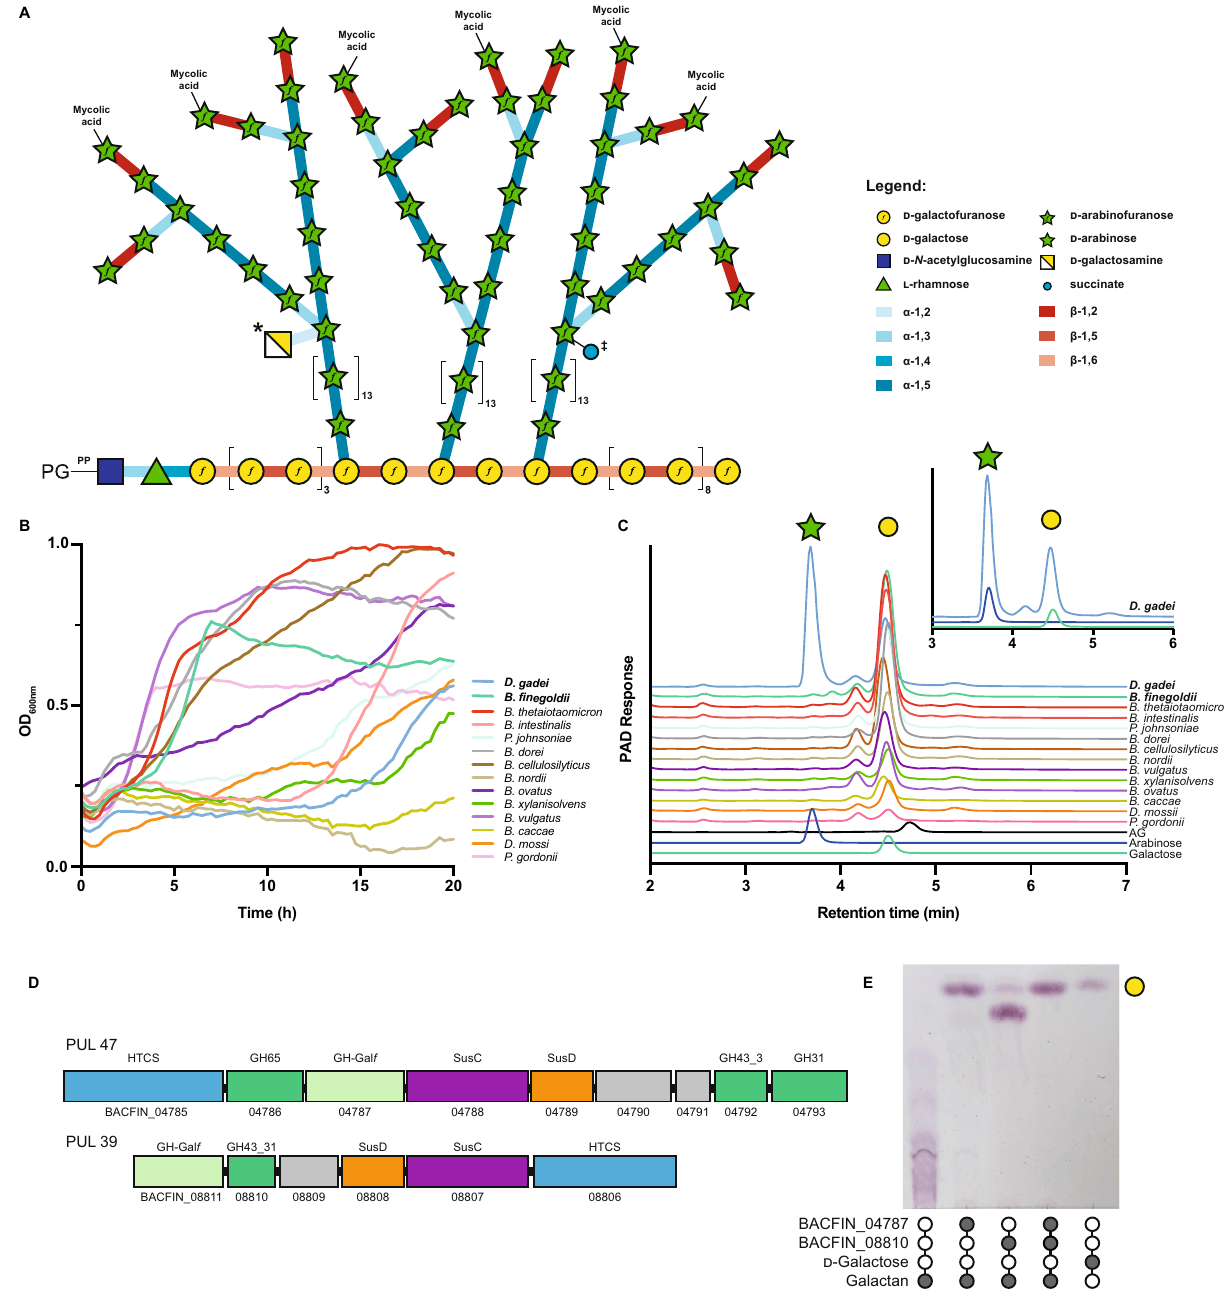
Fig.1|Bacteroidetesgrowthonmycobacterialarabinogalactan.A Schematicof the structure of mycobacterial mycolyl-arabinogalactan-peptidoglycan complex. Succinate( ‡ )andgalactosamine(*)modi fi cationsarenon-stoichiometric. B Growth of selected Bacteroidetes species on arabinogalactan as monitored by change in OD 600nm . C Ion chromatography with pulsed amperometric detection (IC-PAD) analysis of culture supernatants for bacteria grown on mycobacterial AG as a sole- carbon source. Production of arabinose (green star) and galactose (yellow circle) are indicated and compared to standards. Data from D. gadei is also shown as an